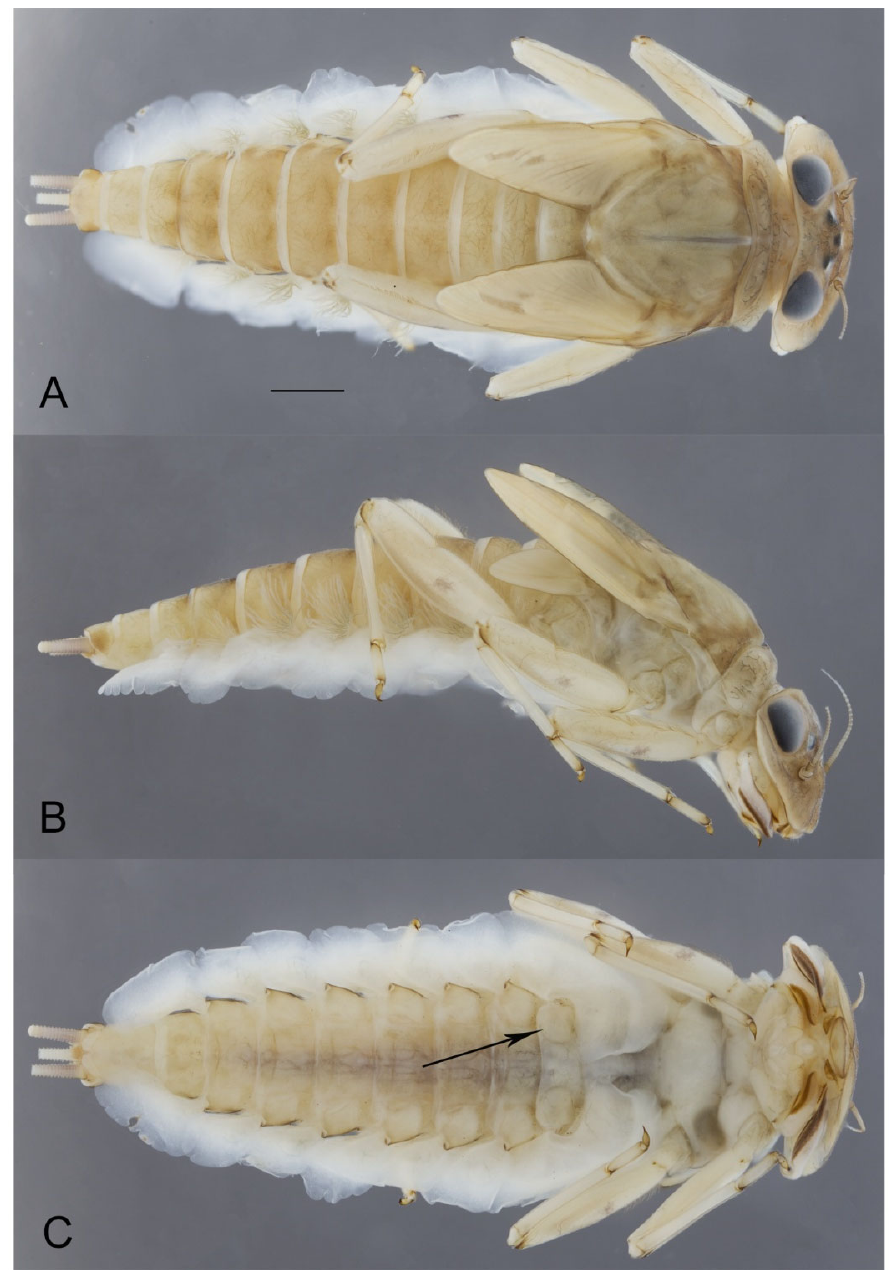
Figure 4. Rhithrogena sartorii , habitus in dorsal view ( A ), lateral view ( B ), and ventral view ( C ). The arrow points to the lateral sclerites of the first sternite. Scale bar: 1 mm.